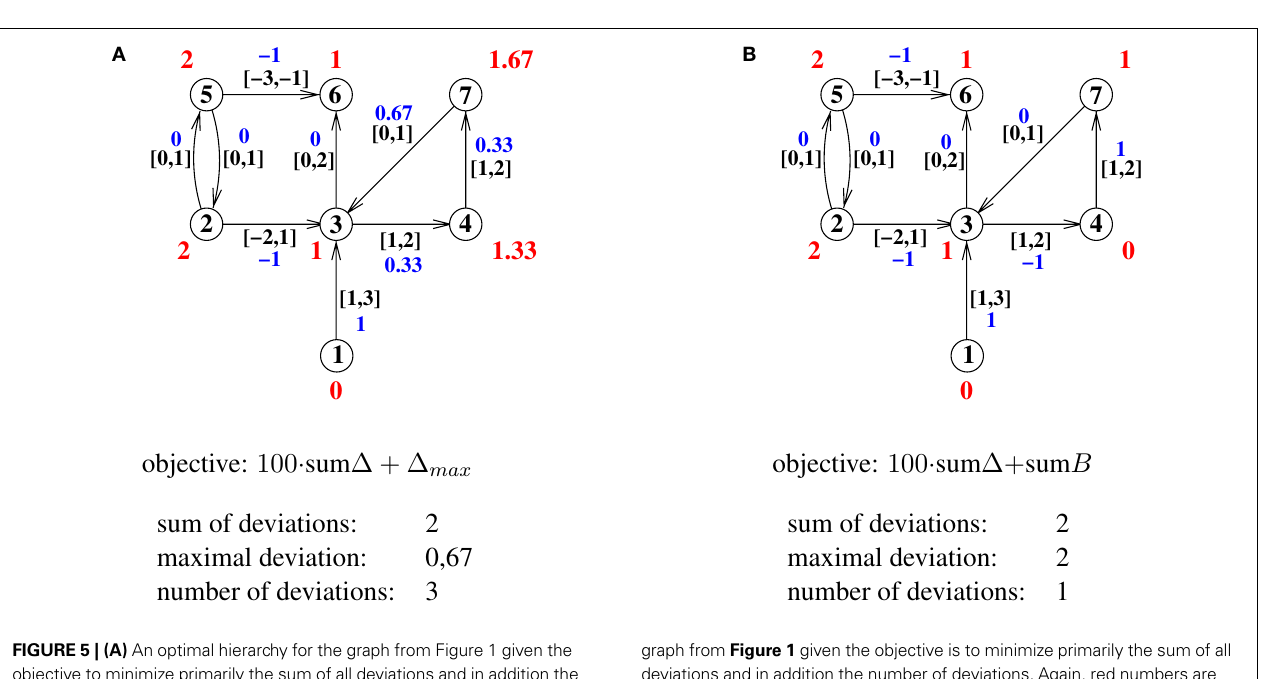
graph from Figure 1 given the objective is to minimize primarily the sum of all deviations and in addition the number of deviations. Again, red numbers are the hierarchy levels of nodes, blue numbers the actual distances in the